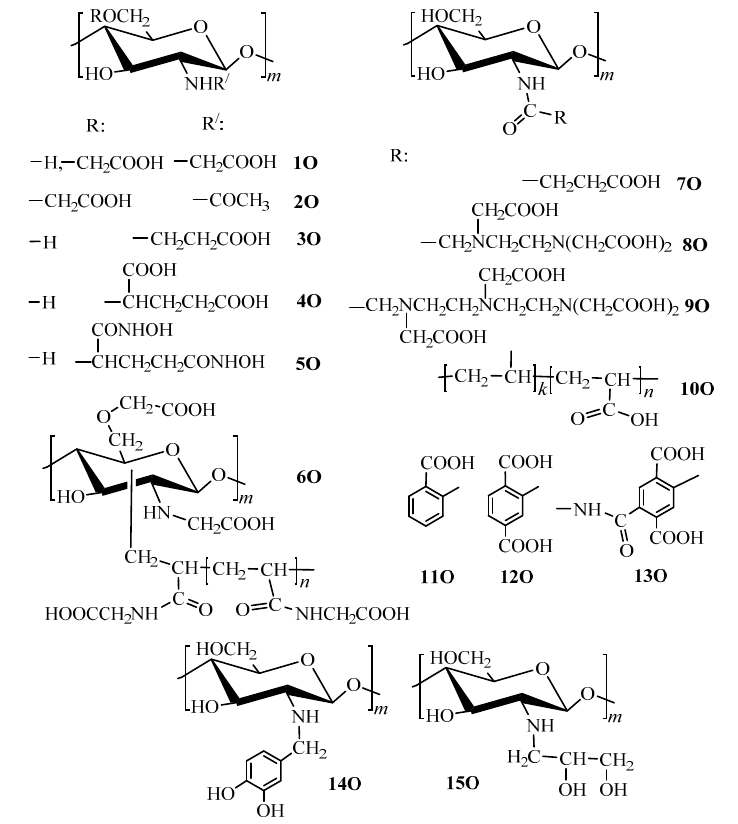
Figure 1. Structures of O-containing derivatives of chitosan without linkers: 1O — N , O -carboxymethyl chitosan; 2O —carboxymethyl chitin; 3O — N -(2-carboxy)ethyl chitosan; 4O —chitosan α -ketoglutaric